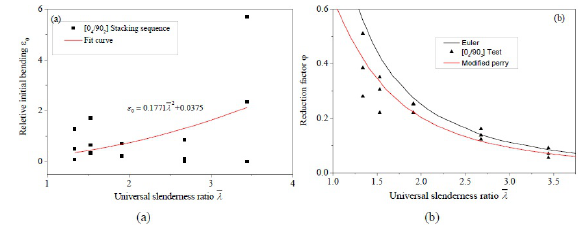
Figure 7: Stacking sequence [0 4 /90 2 ] (a) initial relative bending